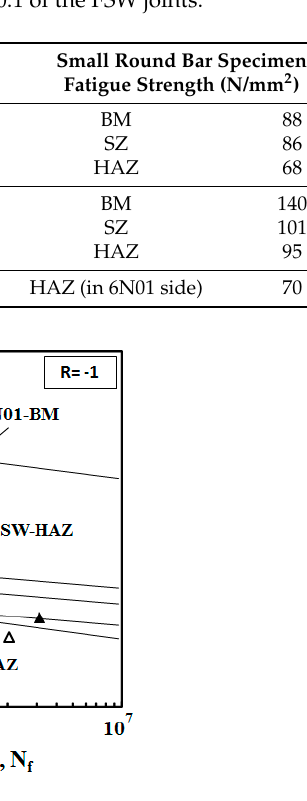
Figure 10. S-N curve for the plate specimens cut from the FSW joints.